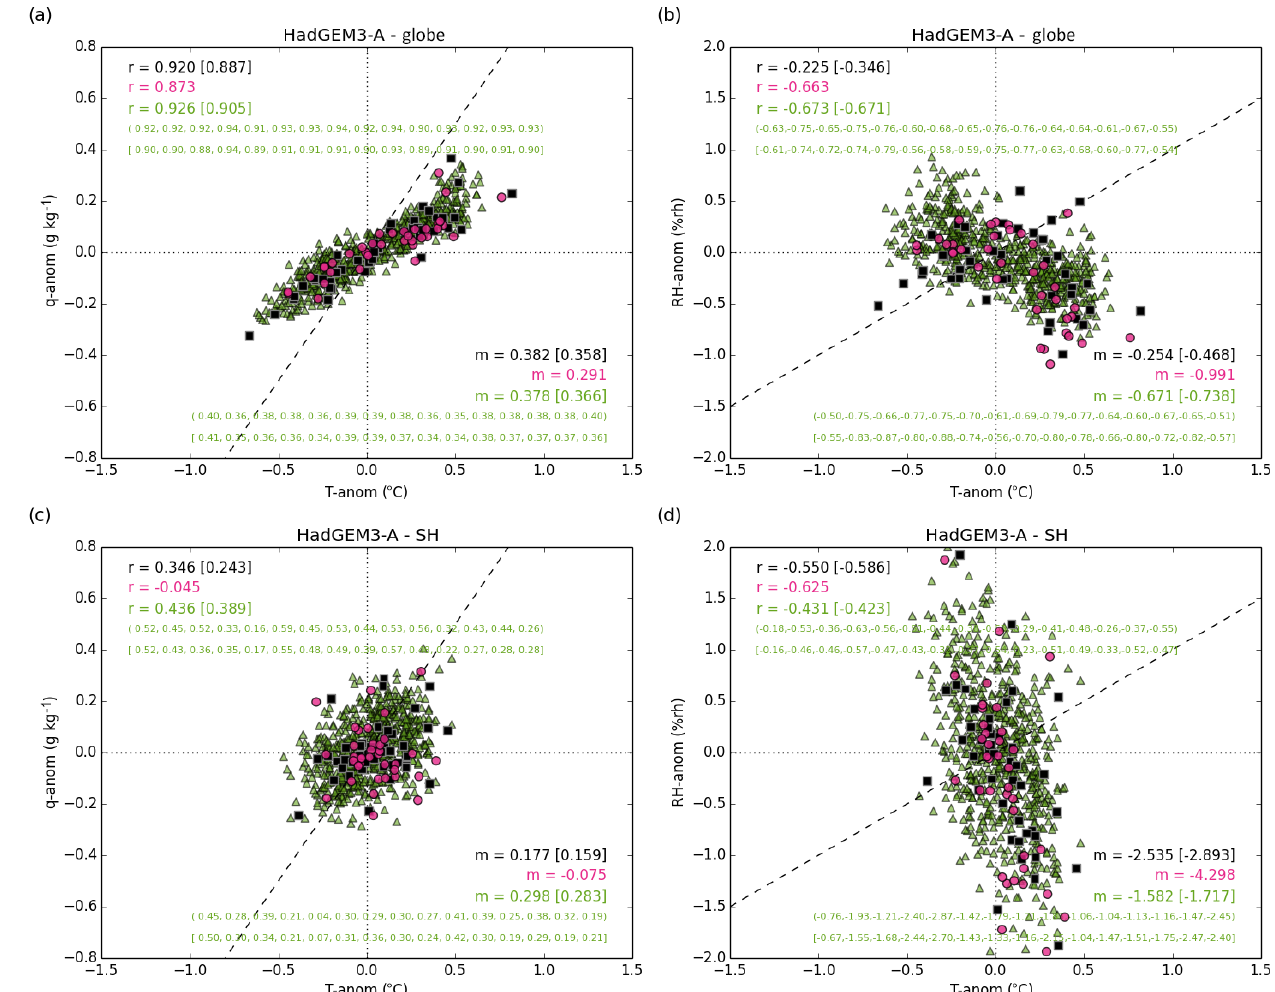
Figure 9. Relationships in global (a, b) and Southern Hemisphere (c, d) average temperature and specific humidity (a, c) and temperature and relative humidity (b, d) for HadGEM3-A compared to HadISDH and ERA-Interim. Correlations ( r ) are shown in the top left-hand corner of each panel. The gradient of the line of best fit is given in the bottom right-hand corner of each panel. HadISDH is shown in black. ERA- Interim is shown in magenta. The ensemble mean value is given for HadGEM3-A with individual member values in parentheses. Values in square brackets are calculated using data matched to the coverage of ERA-Interim, for both HadISDH and